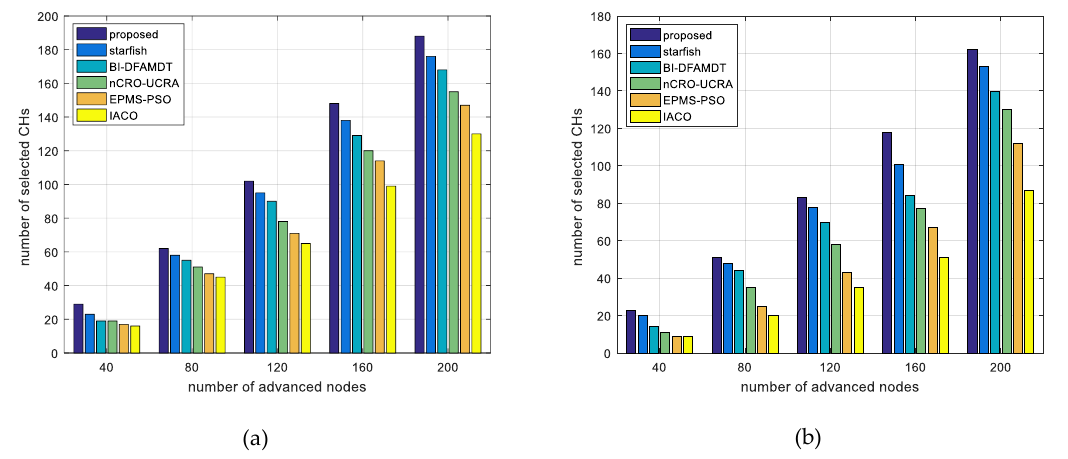
Figure 19. Comparison of the proposed scheme with existing algorithms versus number of selected CHs: ( a ) Simulation graph for scenario 1; and, ( b ) Simulation graph for scenario 2. Table 7. Advanced energy usage results for scenario 1.